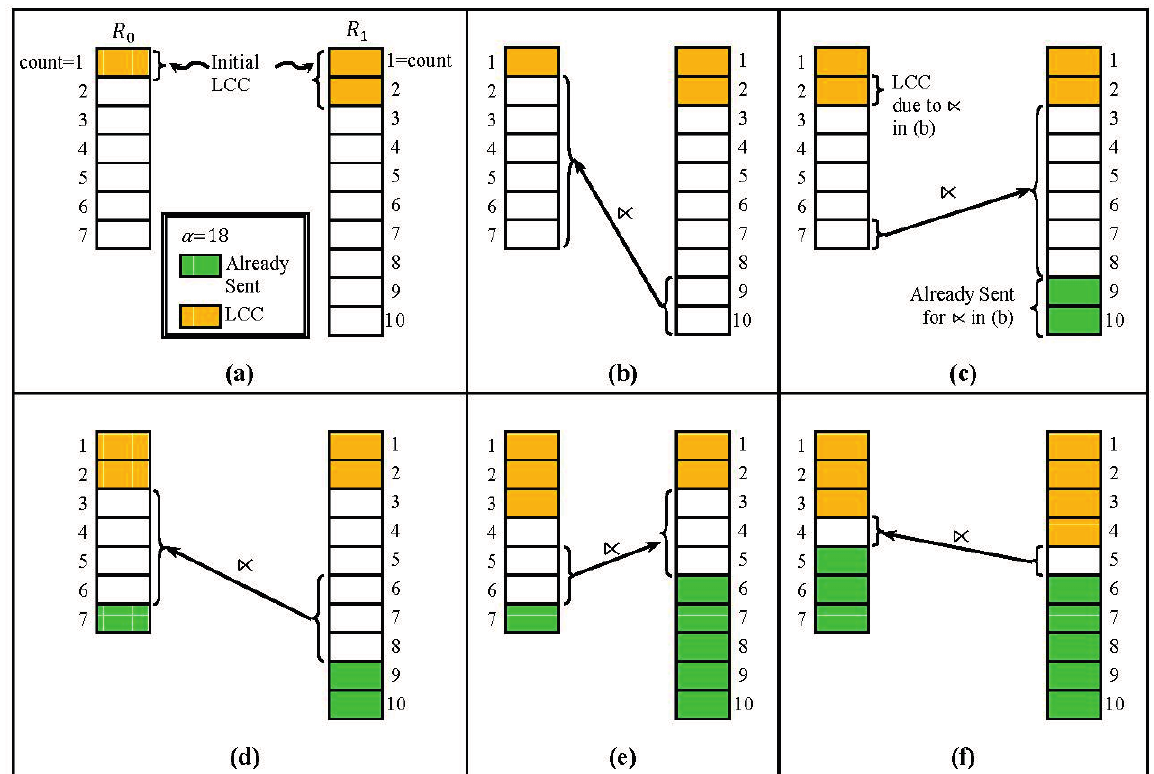
Figure 4. A Sequence of Fragment Semijoins. ( a ) Given (cid:1844)